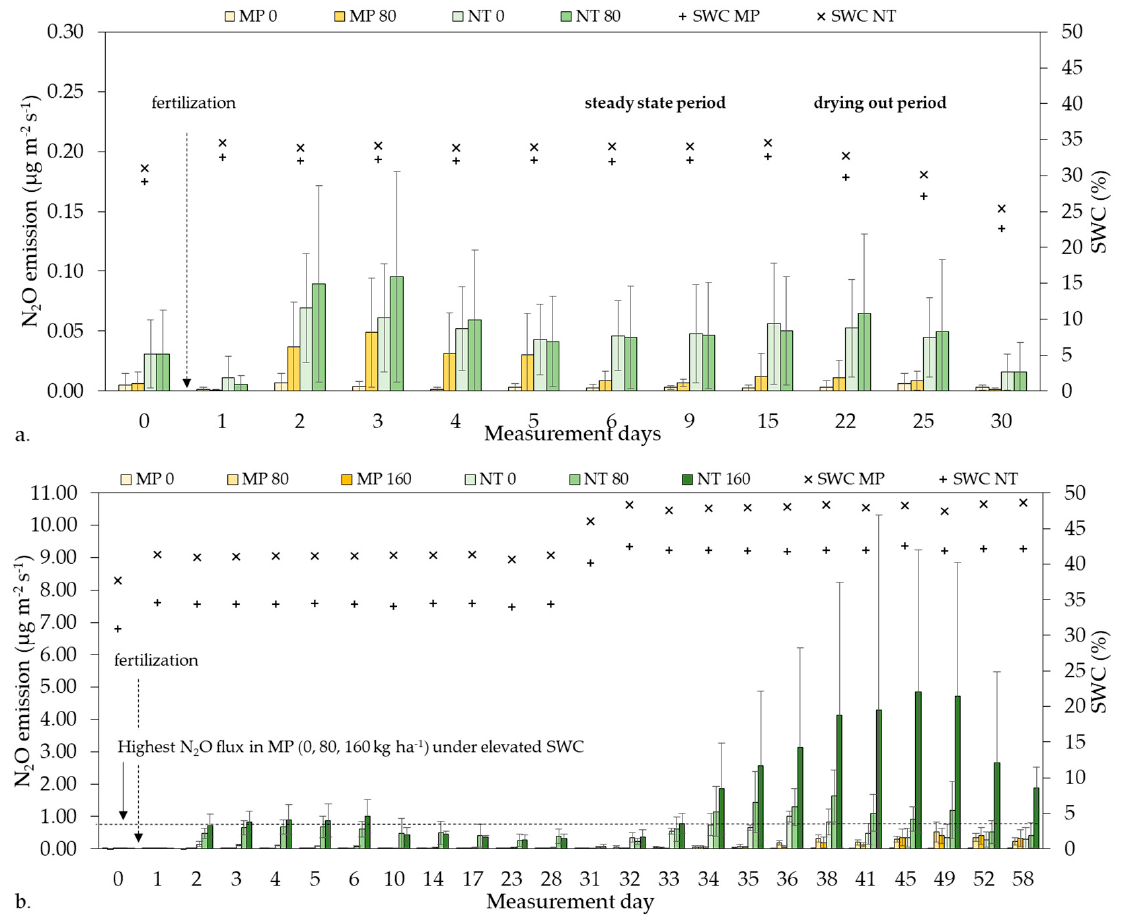
Figure 2. N 2 O emission and soil water content (SWC) in ( a ) Tillage experiment and ( b ) in Fertilizer experiment. Different fertilizer doses: MP 0, 80, 160; NT 0, 80, 160 kg ha − 1 in mouldboard ploughing (MP) and no-tillage (NT), respectively.